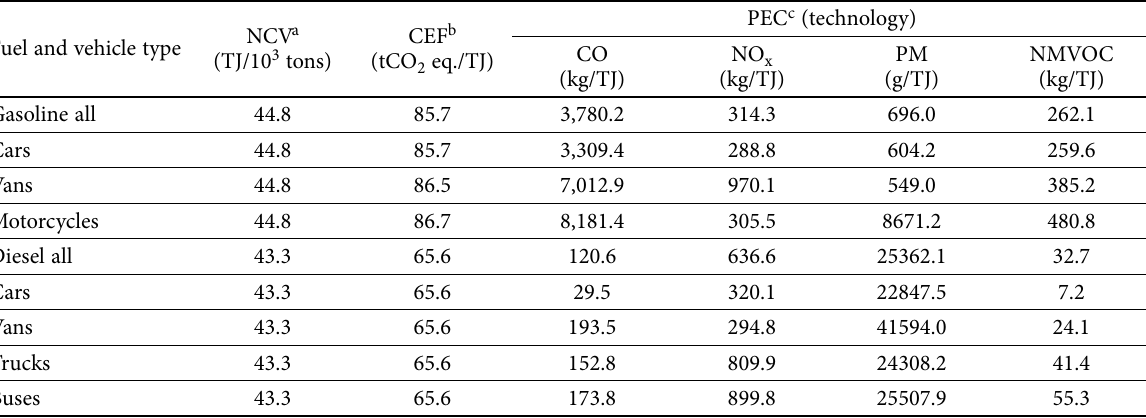
Table 2. Net calorific values, carbon emission factors and pollutant emission coefficients used for gasoline and diesel by vehicle types in Spain (source: IPCC emissions coefficients (1995) and this paper Fuel and vehicle